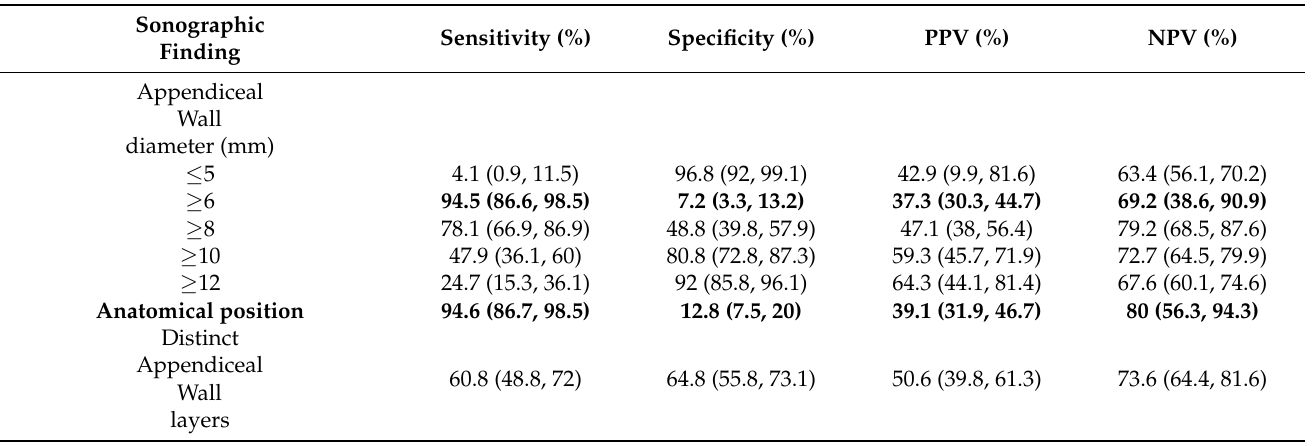
Table 3. Sensitivity and specificity values of US findings for